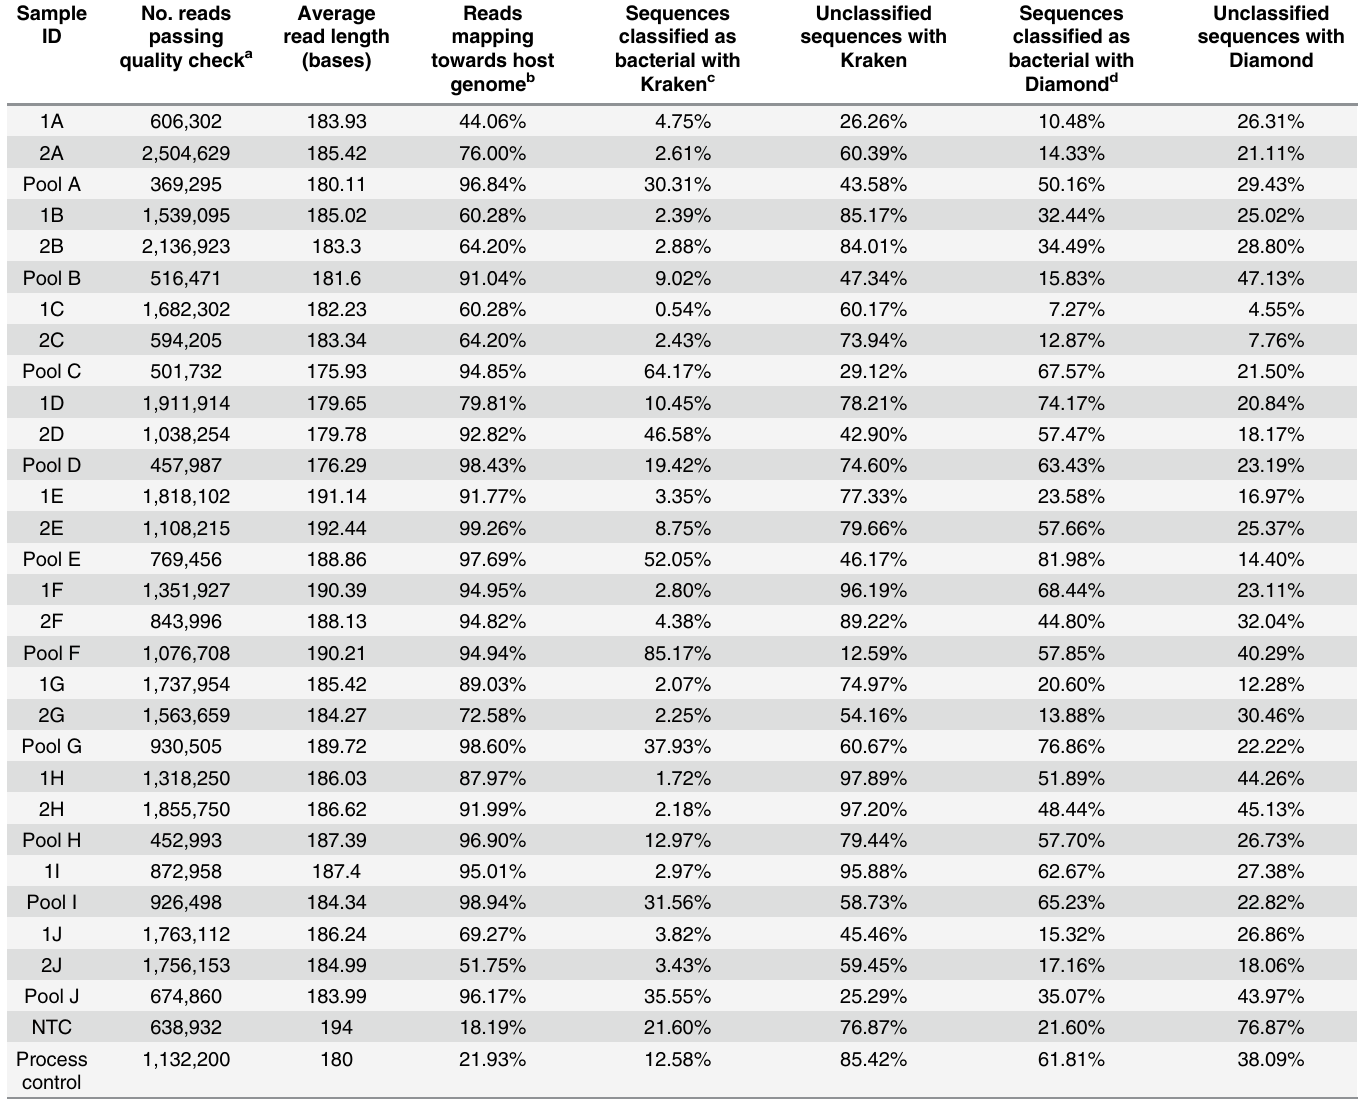
Table 2. Overview of sequencing results and initial filtering and read classification. Sample